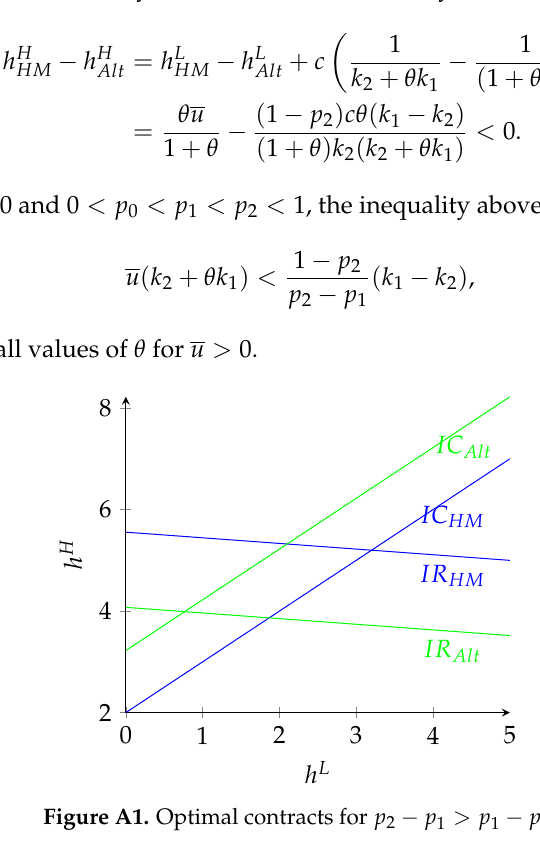
p 1 > p 1 p 0 . − − p 1 < p 1 p 0 − −